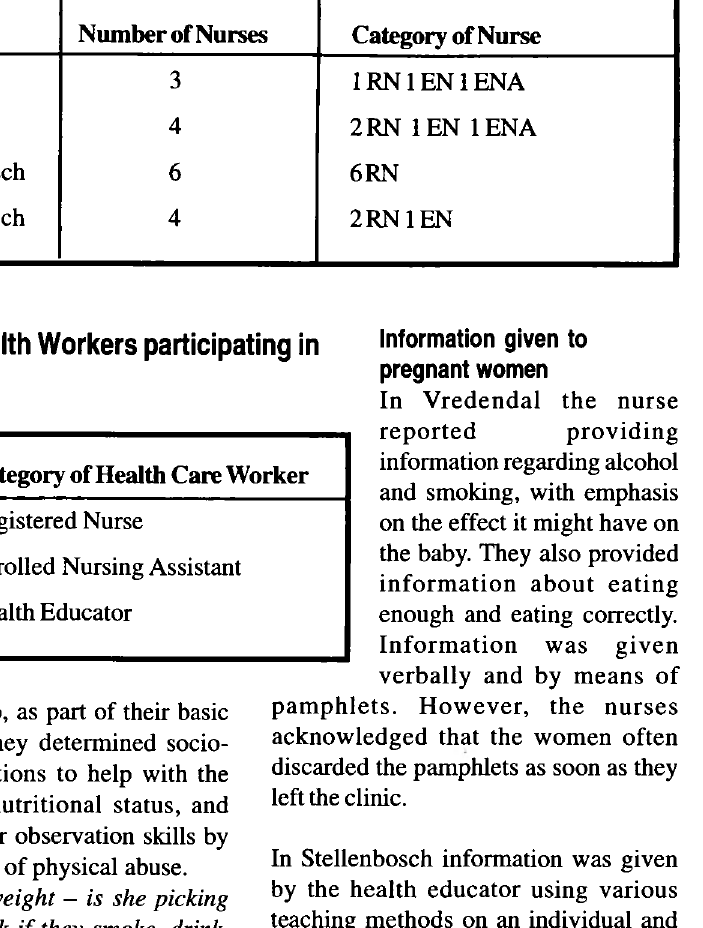
Table 2b: Description of Health Workers participating in Semi-structured